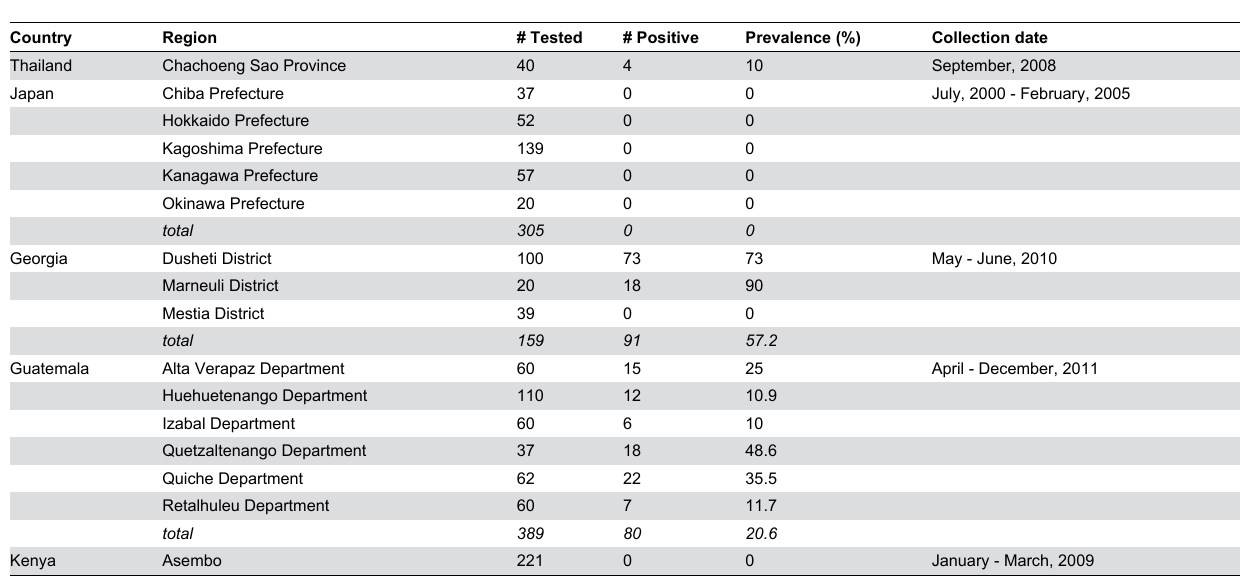
Table 1. Distribution of bartonella infection in cattle from different geographic regions.